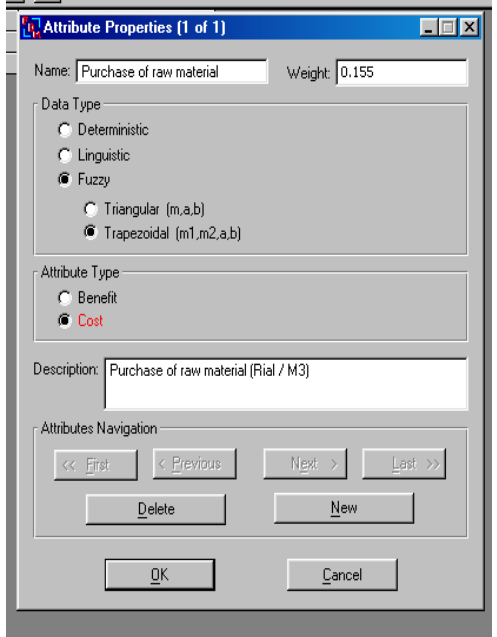
Figure 3: Description of the criteria in FDM (A